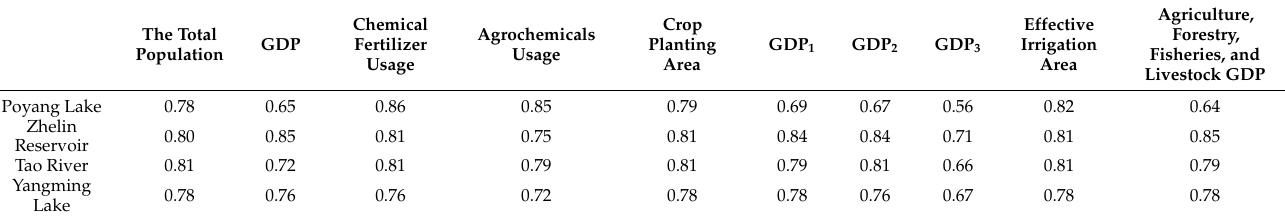
Table A1. Grey correlation of socio-economic factors.